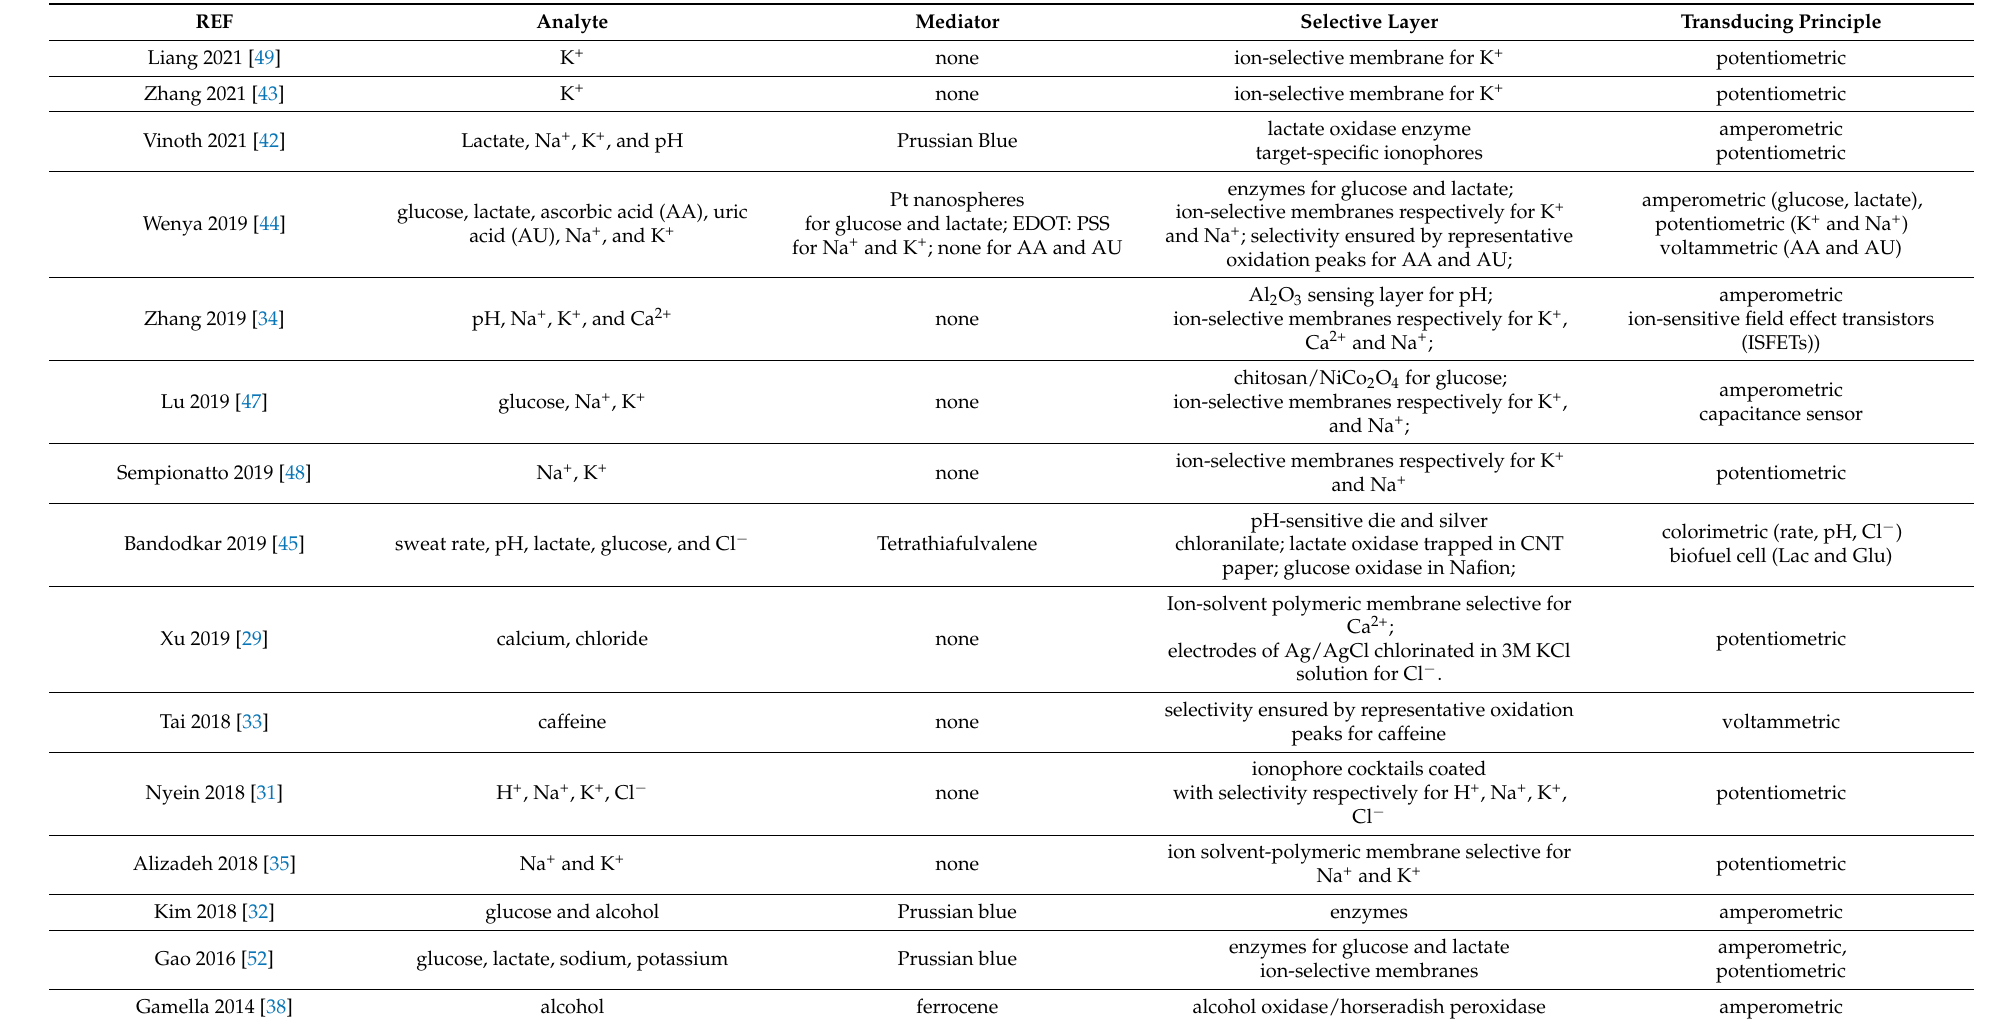
Table 1. Summary of specific analytes and transducing